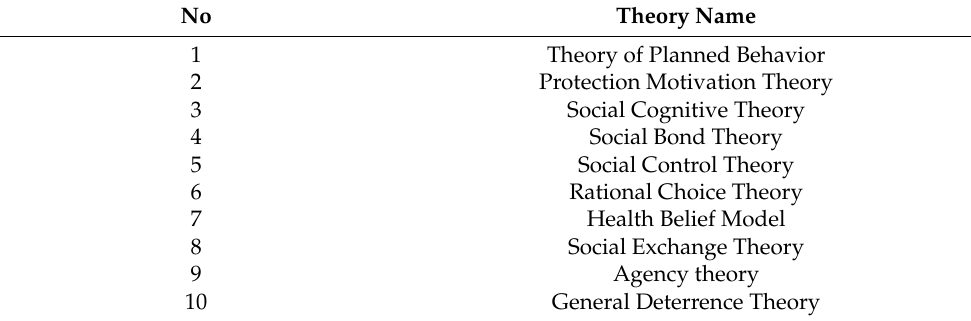
Table A3. The most common theories used for compliance studies.